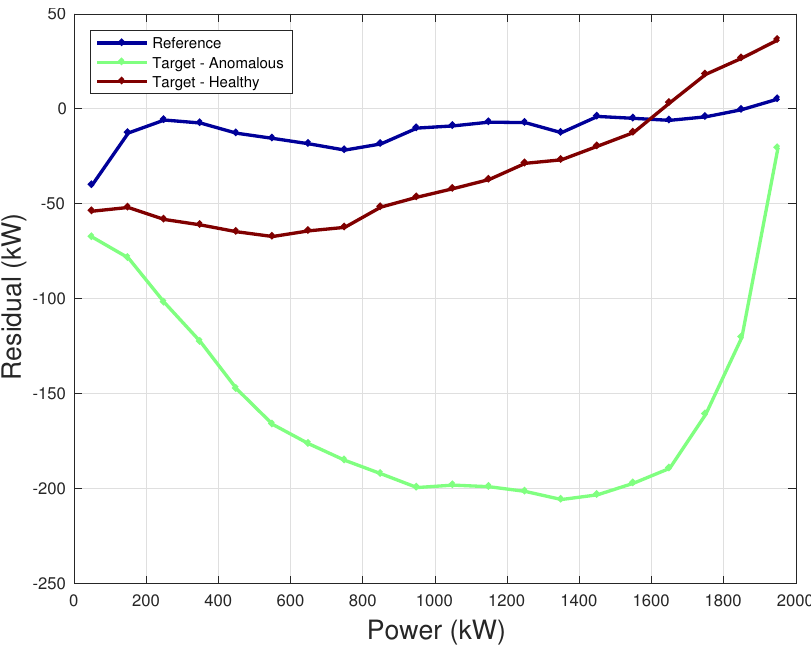
Figure 10. Residuals between measurements and model estimates as a function of the measured power: reference wind turbine, target anomalous, and target